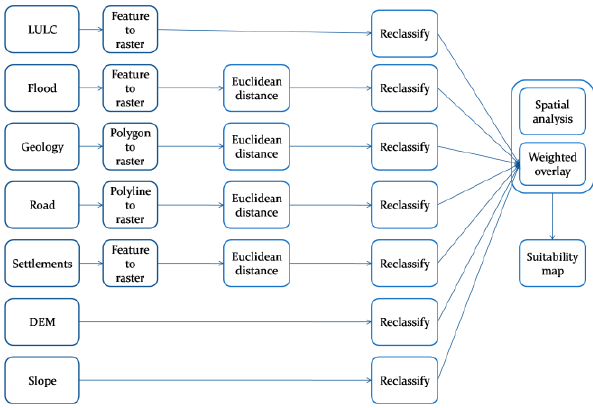
Fig 7: GIS model to implement AHP technique